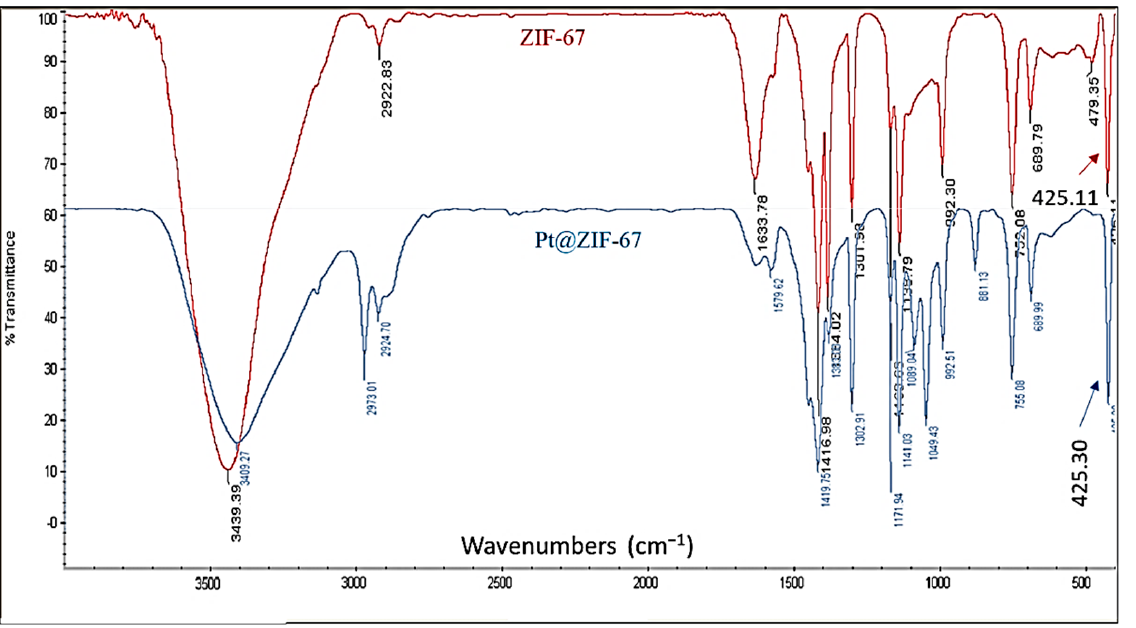
Figure 2. Comparison of FTIR spectra of ZIF-67 and Pt@ZIF-67.